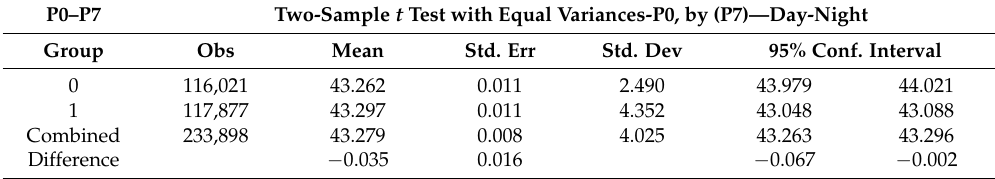
Table 6. Results: P0 by P7: Variability 35 nT between 0 and 1 with p -value: 0.358.